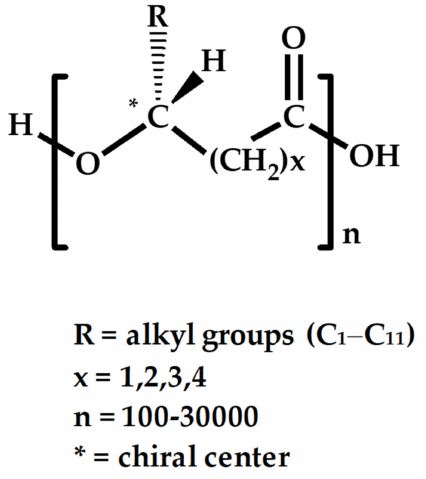
Figure 1. A generic chemical structure of polyhydroxyalkanoate biopolymer. PHA is regularly categorized into two categories: short chain length (scl-PHAs) with four to five carbons, such as poly(3-hydroxyvalerate), (PHV) and poly(3-hydroxybutyrate), (PHB) and medium chain length (mcl-PHAs) with six to thirteen carbons,